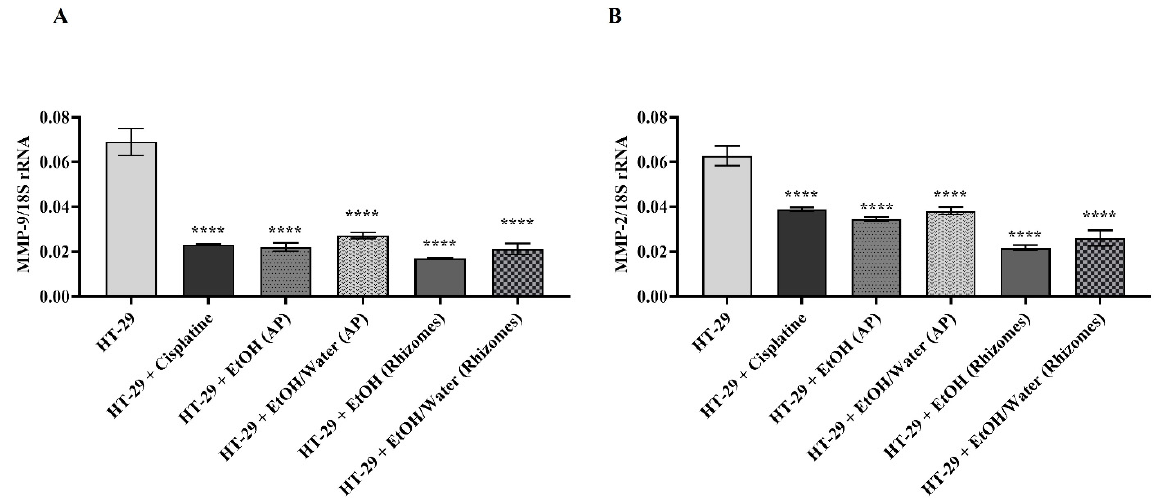
Figure 9. Effect of 50 µ g/mL EtOH and EtOH/water extracts obtained from aerial and root parts of Primula auriculata on MMP-9 (in ( A )) and MMP-2 (in ( B )) mRNA gene expression levels. The 18sRNA gene was used as a reference gene to detect changes in target gene levels in the HT-29 cell line. In GraphPad Prism 8 statistical analysis, **** was used for p ≤